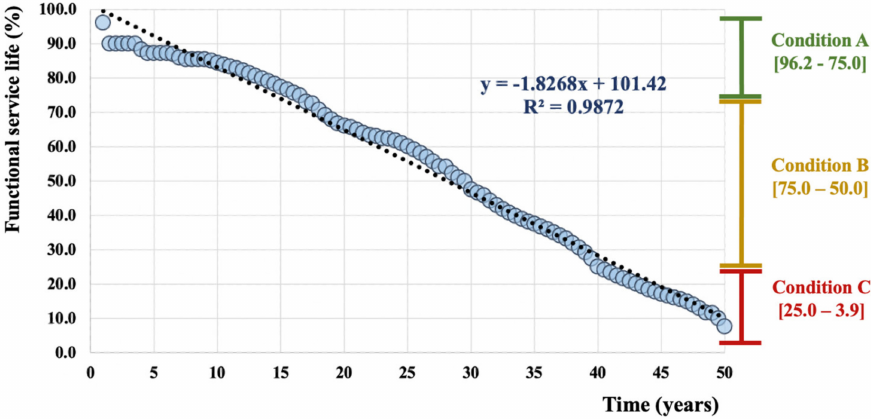
Figure 8. Functional degradation evolution concerning the sensitivity analysis of the FSL-CP